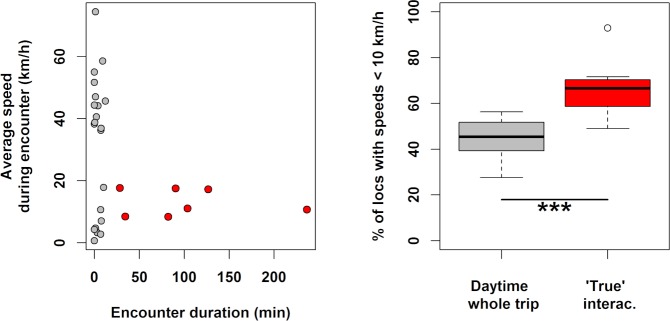
Vessel encounter characteristics.(Left): Average Cape gannet traveling speed and contact duration of 28 radar “encounters” by gannets (from 13 individuals), used for visual categorization; the seven encounters identified as true attendance (from 5 individuals) are highlighted in red. (Right): Proportions of speeds < 10km.h-1 during trips as a whole (during day time hours: left) or during the seven “true” attendance (right, red, ***: Wilcoxon test, p < 0.001).